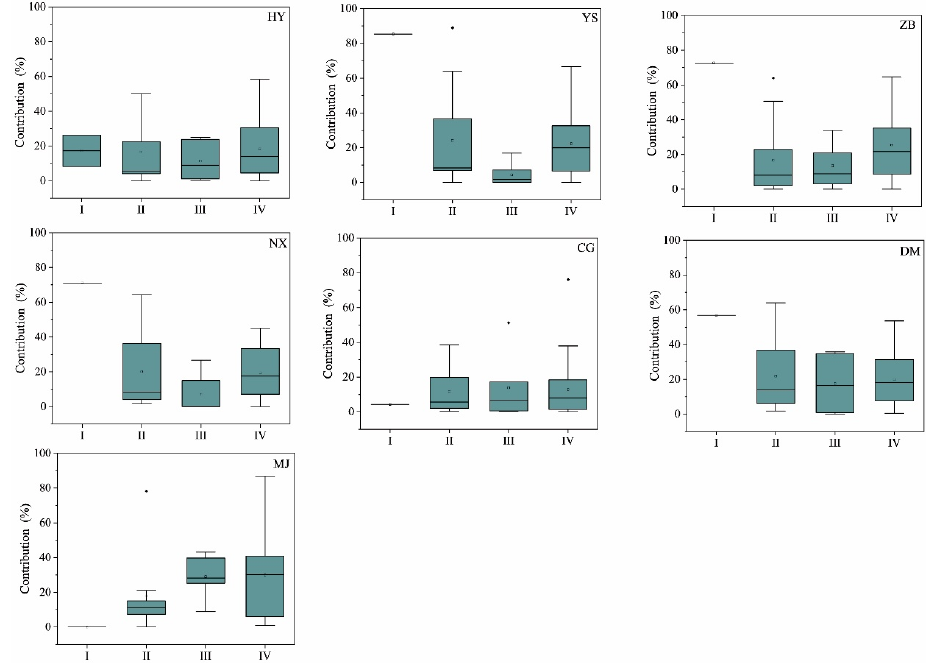
Figure 12. Monthly contribution of TC precipitation for the four track patterns.